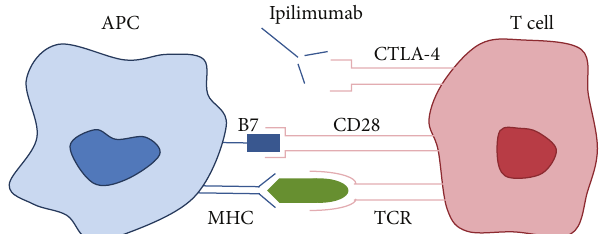
Figure 2: APC: antigen presenting cell. MHC: major compatibility complex. TCR: T cell receptor. Adapted from K¨ahler and Hauschild [1].